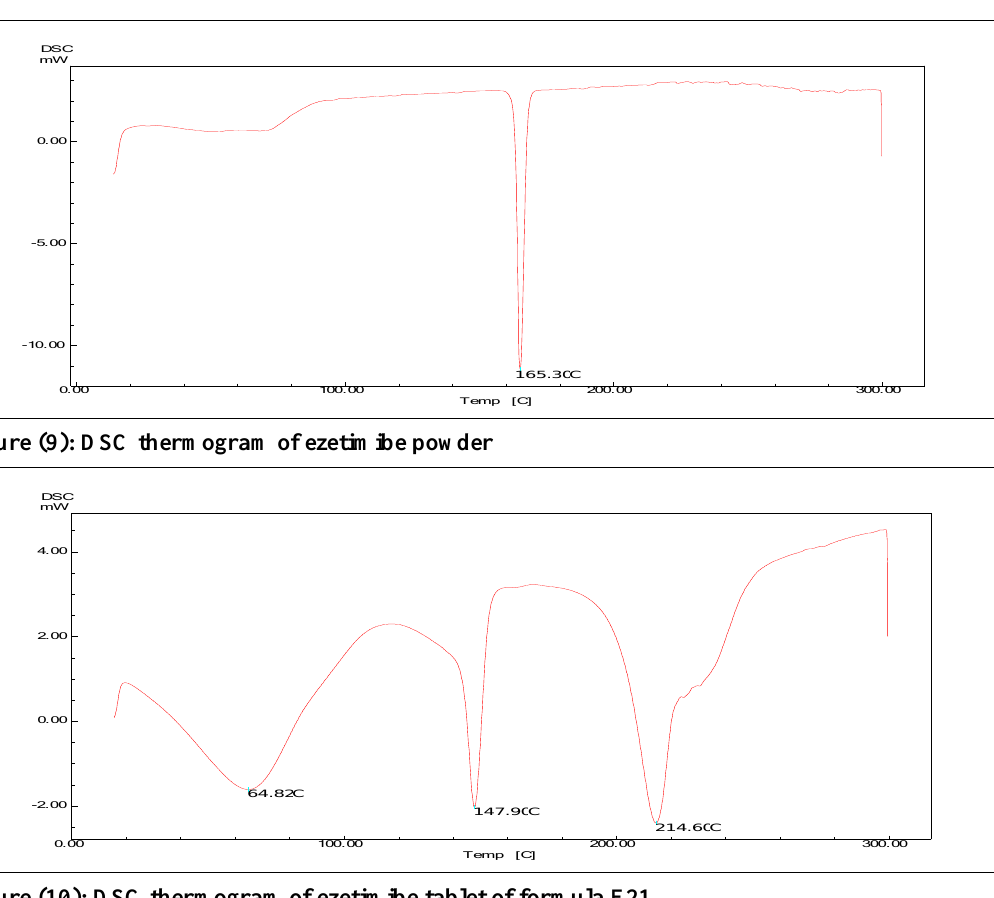
Figure (10): DSC thermogram of ezetimibe tablet of formula